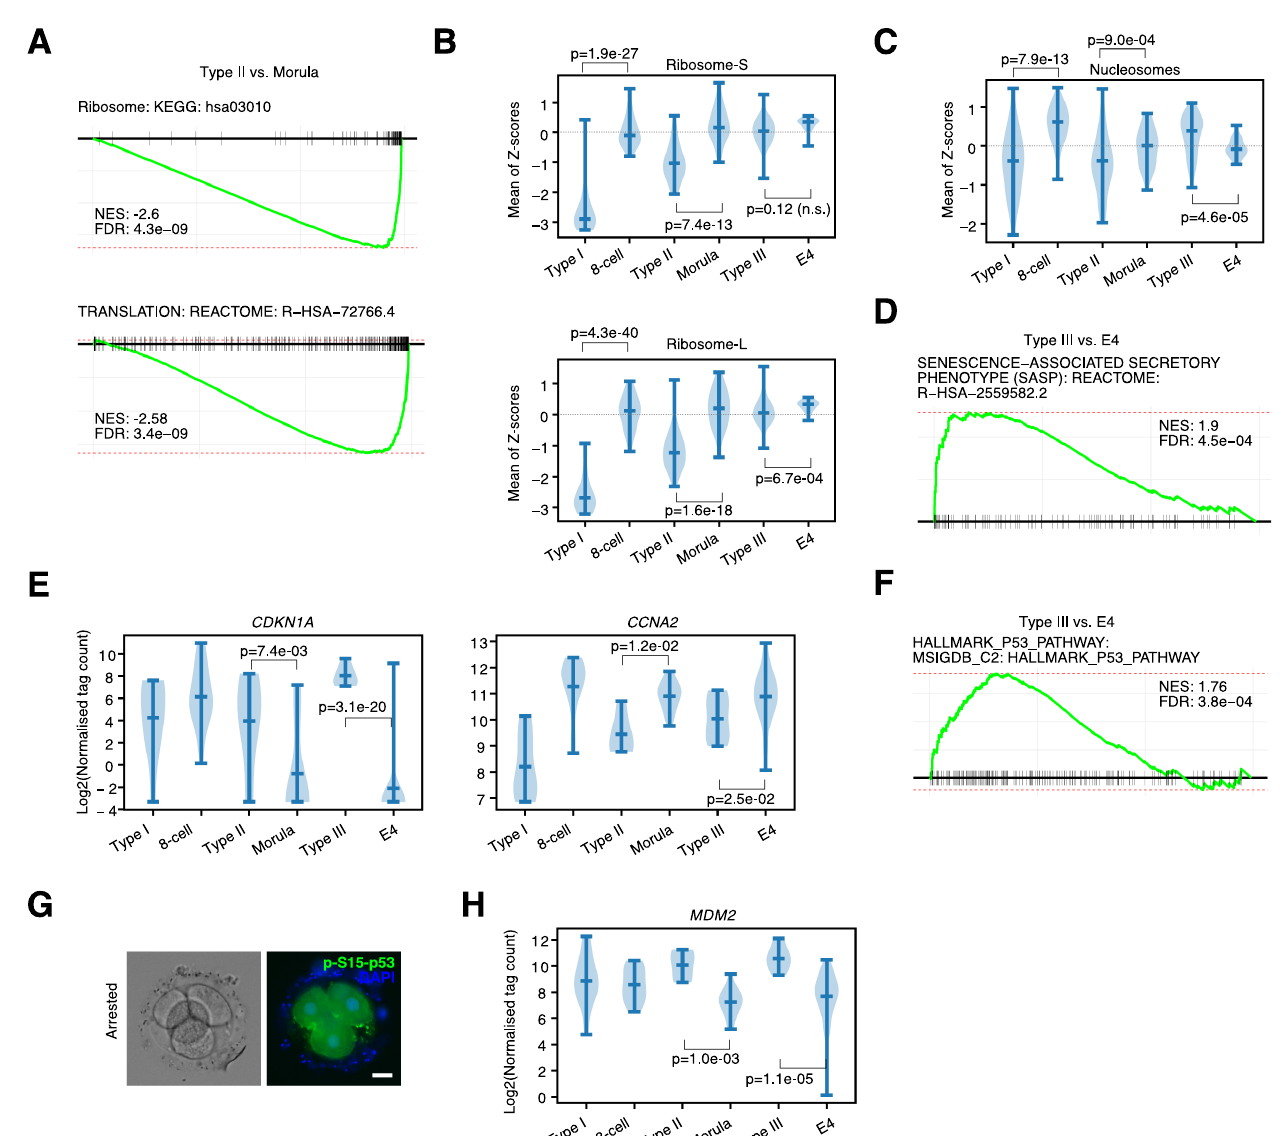
Fig 3. Arrested embryos down-regulate histones, ribosomes, and adopt a senescent-like gene expression program with elevated p53 activity. ( A ) GSEA for differentially expressed genes in the Type II versus morula comparison. Underlying data can be found in S5 Data . ( B ) Violin plot of the means of the Z- scores for all small (top) and large (bottom) ribosomal subunits in the indicated embryonic stages or arrested embryos. Significance is from a 2-sided Welch’s t test. Underlying data can be found in S1 Data . n.s. = not significant. ( C ) Violin plot of the means of the Z-scores for all expressed nucleosomes in the indicated embryonic stages or arrested embryos. Significance is from a 2-sided Welch’s t test. Underlying data can be found in S1 Data . ( D ) GSEA showing the SASP term is significantly enriched in Type III versus E4 (late morula) comparison. Underlying data can be found in S5 Data . ( E ) Violin plot showing the expression of CDKN1A (p21), or CCNA2 in the indicated embryonic stages or arrested embryos. Significance is from a 2-sided Welch’s t test. Underlying data can be found in: https://figshare.com/articles/dataset/Human_embryo_normalized_gene_expression_data/19775992. ( F ) GSEA showing the enrichment of the HALLMARK p53 list of target genes is significantly enriched in Type III versus E4 (late morula) comparison. Underlying data can be found in S5 Data . ( G ) Phospho-S15-p53 (green) immunostaining in arrested embryos. Embryos are co-stained with DAPI (blue), scale bar = 20 μ m. ( H ) Violin plot of expression showing the expression level of the p53 target gene MDM2 in the indicated embryonic stages or arrested embryos. Significance is from a 2-sided Welch’s t test. Underlying data can be found in: https://figshare.com/articles/dataset/Human_embryo_normalized_gene_expression_data/ 19775992. GSEA, gene set enrichment analysis; SASP, senescence-associated secretory phenotype.